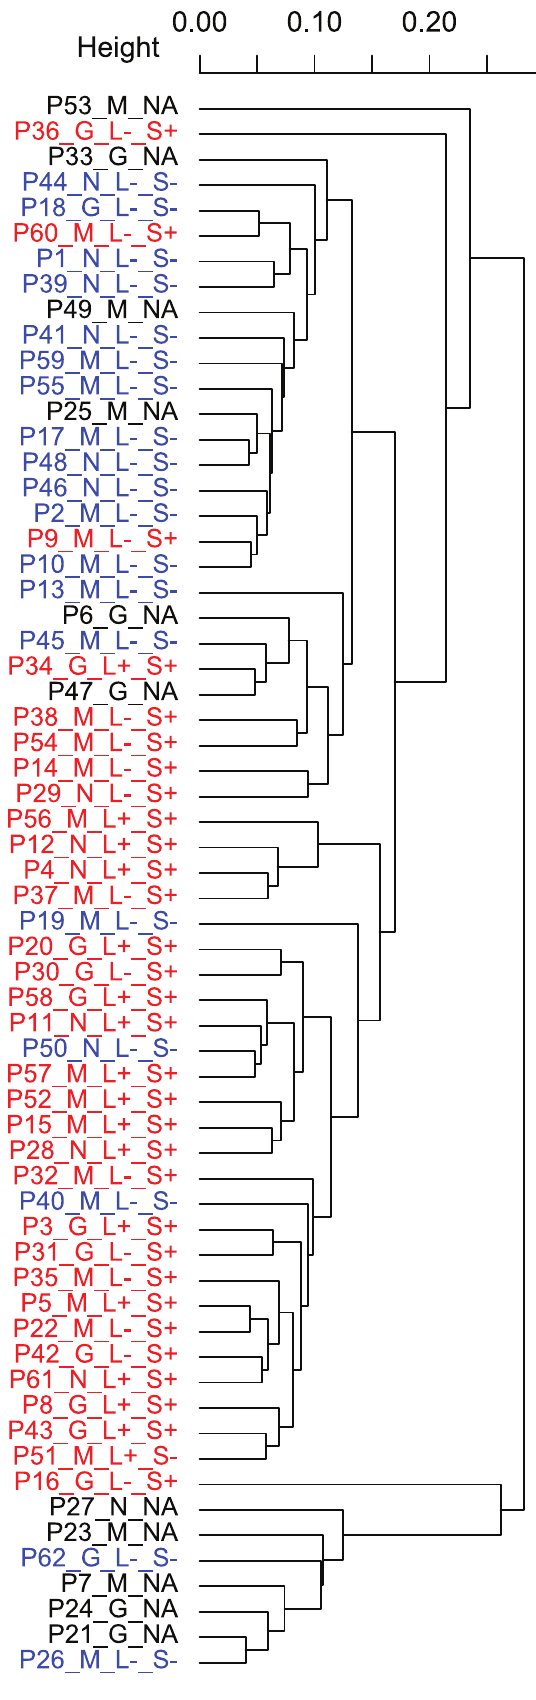
Figure 2. Hierarchical cluster of patients using features with high variation irrespective of response group. Patients were clustered in a hierarchical dendrogram using features with a log 2 -ratio (ratio=sample intensity/reference intensity) interquartile range . 1 (1321 features in total). Abbreviations in the dendrogram: PXX=Patient number; G, =Good responder; M=Moderate responder; N=Non responder; L + / 2 =presence of large lymphocyte aggregates; S + / 2 presence of small aggregates. Colors in the dendrograms: Red=patients positive for either small or large lymphocyte aggregates; Blue=patients negative for small and large lymphocyte aggregates; Black=patients with no lymphocyte aggregate assessment.